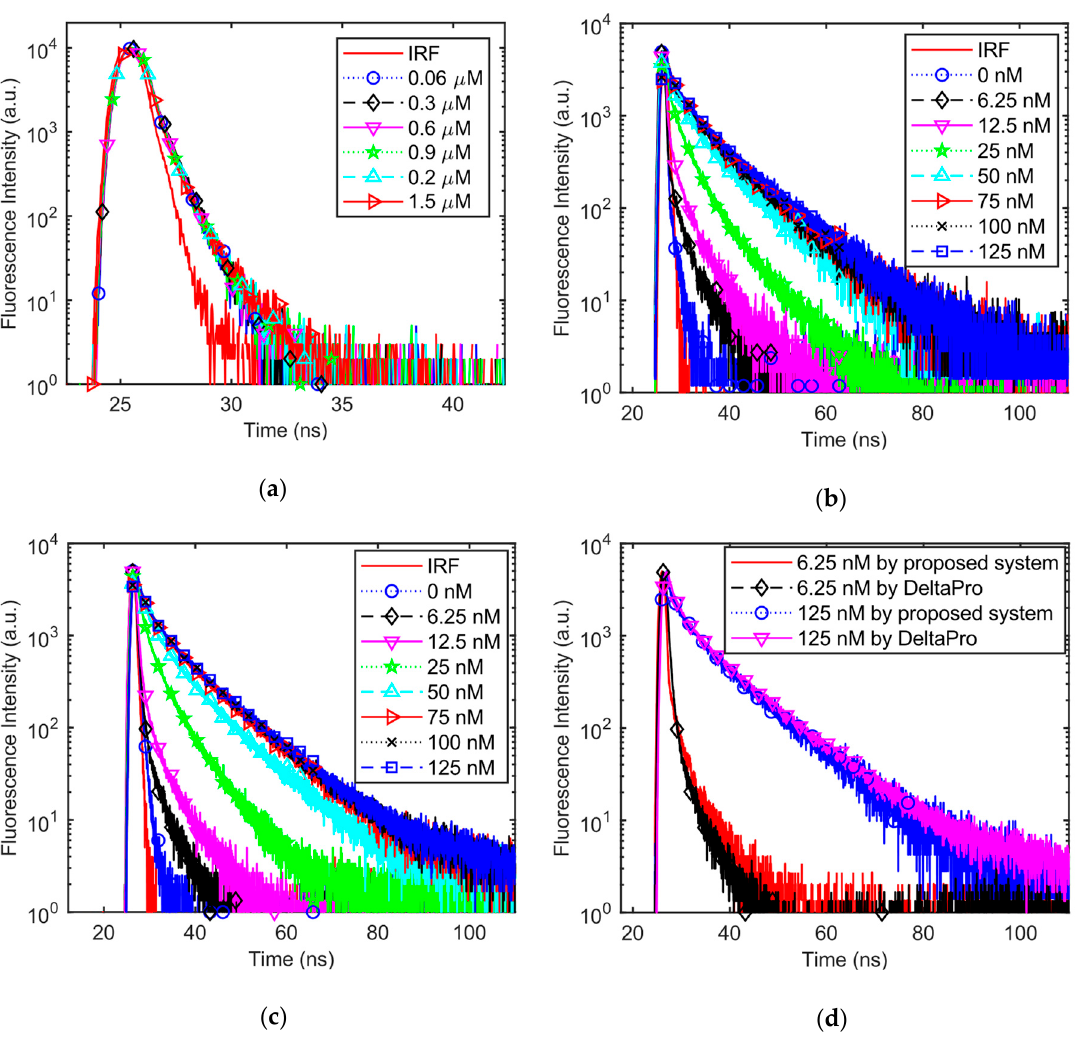
Figure 9. Measured instrument response function (IRF) and decays of the V-carbazole fluorophore with and without dsDNA. ( a ) IRF and the fluorescence decays of V-carbazole only (i.e., without DNA); ( b ) IRF and the fluorescence decays of 0.6 µ M V-carbazole bound with DNA in various concentrations, measured by the proposed system; ( c ) IRF and the fluorescence decays of 0.6 µ M V-carbazole bound to DNA, measured by DeltaPro (for comparison); ( d ) fluorescence decays of 0.6 µ M V-carbazole bound to 6.25 nM and 125 nM DNA, measured by both systems.